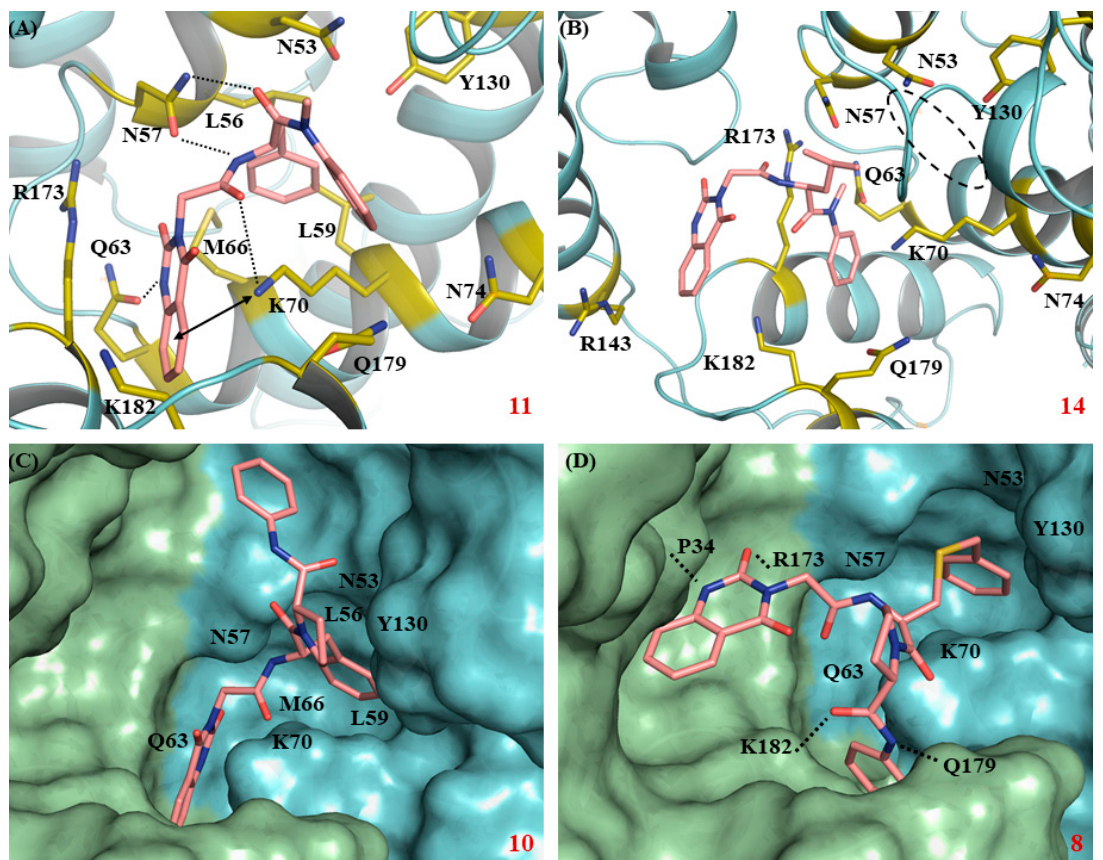
Figure 3. Docking poses of key ligands based on native HIV-1 capsid protein bound to PF74 (PDB code: 4XFZ [25]). ( A ) Predicted binding mode of 11 . Glide score (kcal/mol): -6.3. ( B ) Predicted binding mode of 14 away from the preferred binding site (circled). Glide scores (kcal/mol): -4.2. ( C ) Predicted binding and fitting of L -proline analog 10 within the preferred PF74 binding cavity. Glide score (kcal/mol): -6.3. ( D ) Predicted binding and fitting of L -cysteine derivative analog 8 away from the preferred PF74 binding site. Glide score (kcal/mol): -5.2. Ligands numbers 8 , 10 , 11 , and 14 are in pink. In Figure A and D, H-bond and cation- π interactions are depicted as black dotted lines and double headed arrow, respectively. In ( A ) and ( B ), the capsid protein chain is colored cyan and key residues around binding site are colored olive. In ( C ) and ( D ), CA NTD around helices H3 and H4 in chain A are colored cyan, and CA CTD around helices H8 and H9 in the adjacent chain B are colored green. The nitrogen, oxygen, and sulfur atoms are colored blue, red, and yellow, respectively.